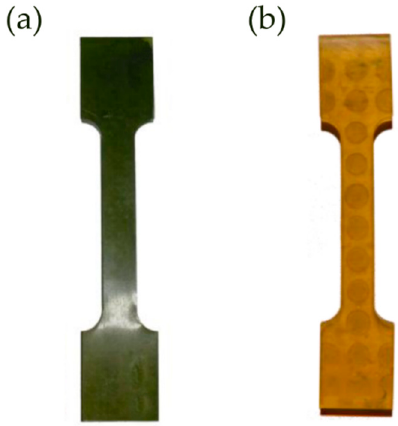
Figure 3. Two examples of dog-bone tensile samples. ( a ) Sample printed with Op resin. ( b ) Sample printed with Cl resin